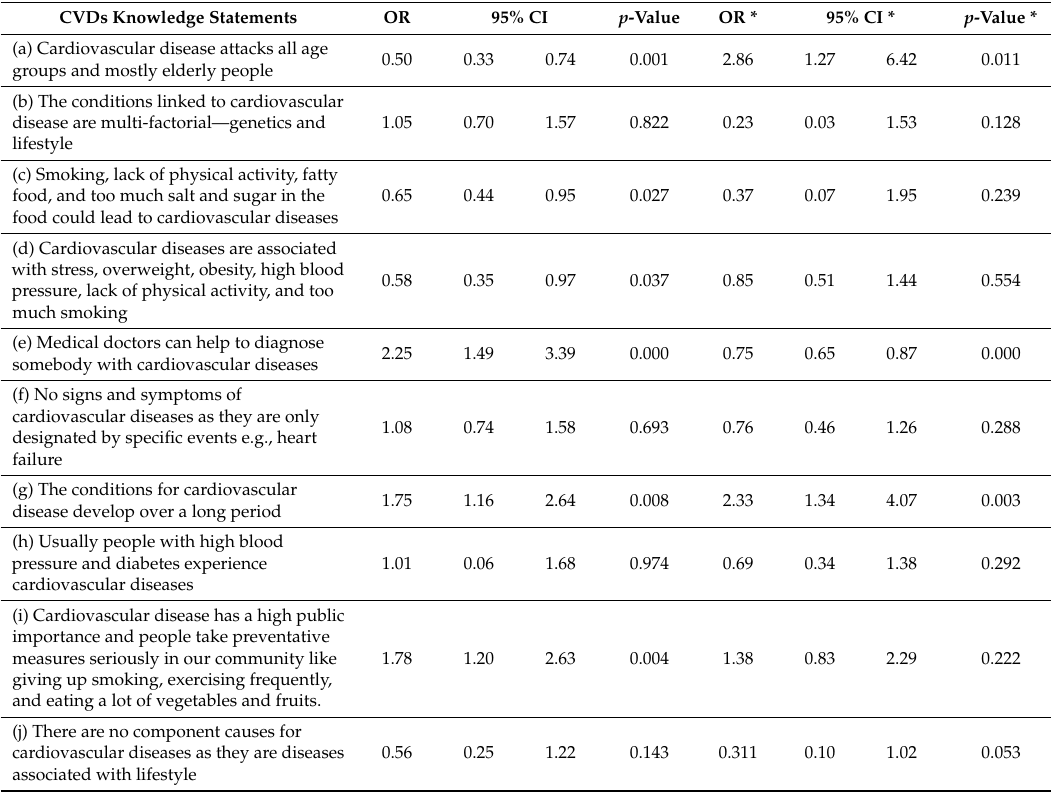
Table 6. Odds ratio and 95% confidence interval for the association of alcohol usage and the knowledge of cardiovascular diseases among Ellisras rural adolescence and young adults (boys, n = 736 and girls, n = 673) aged 14–22